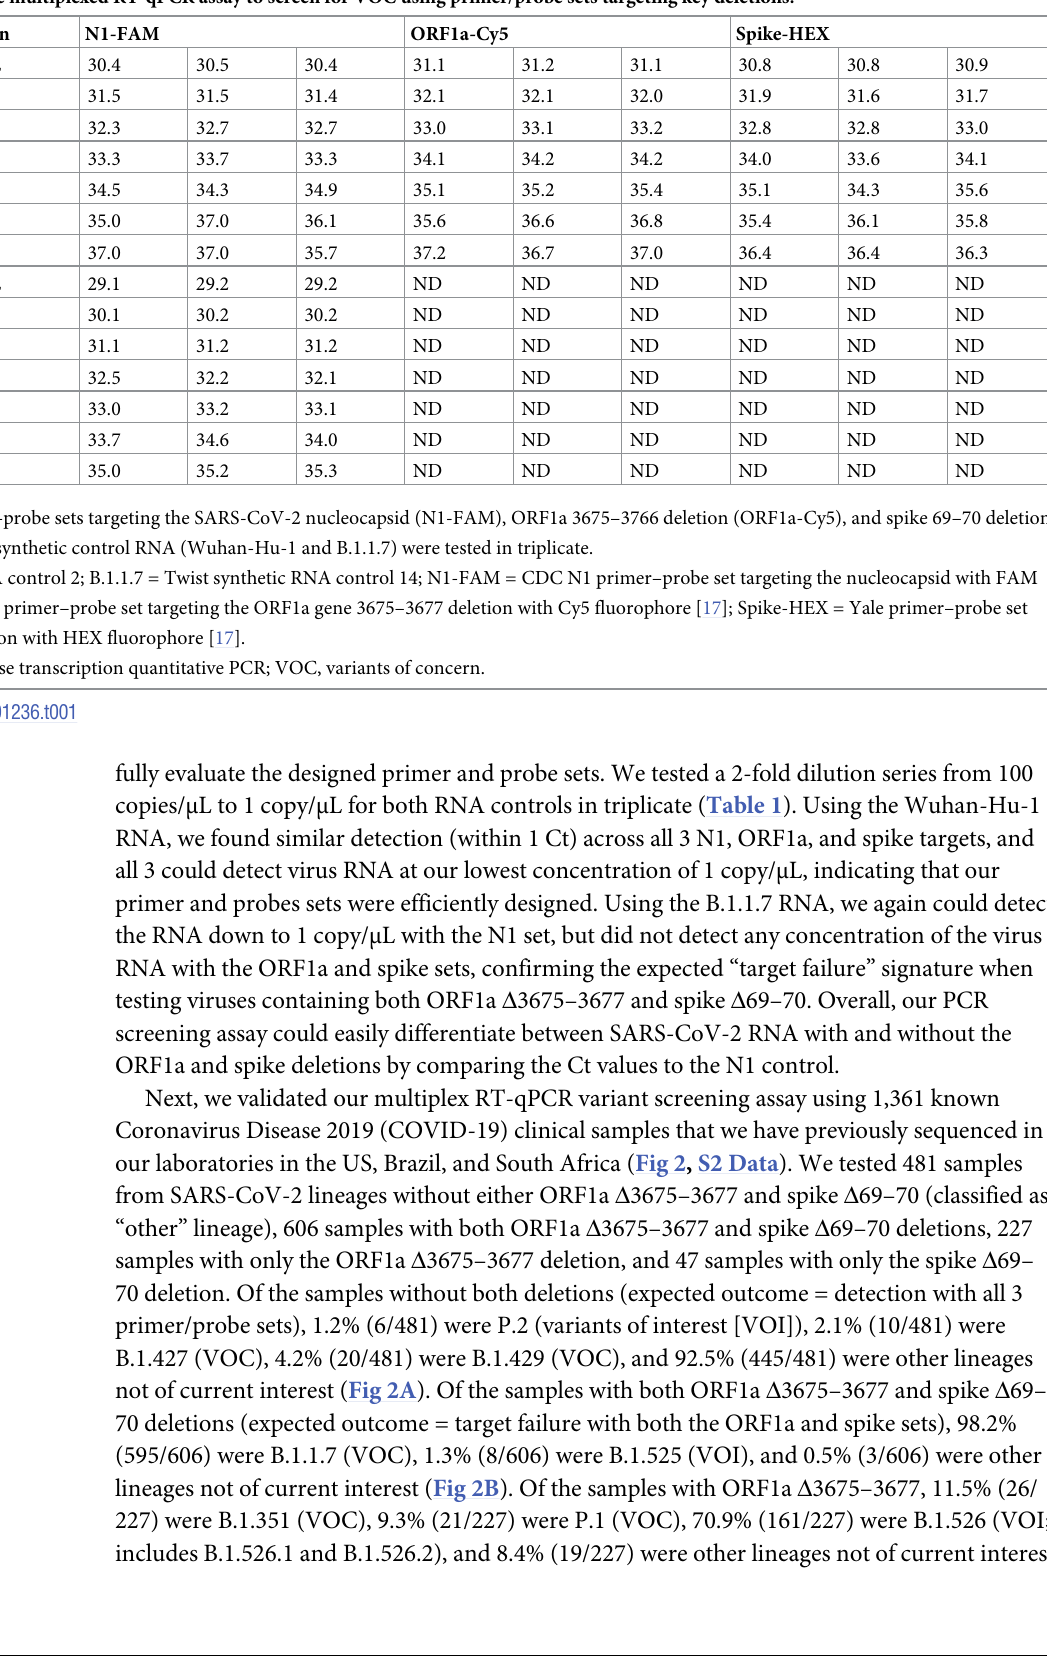
Table 1. Analytical sensitivity of the multiplexed RT-qPCR assay to screen for VOC using primer/probe sets targeting key deletions. RNA Concentration N1-FAM